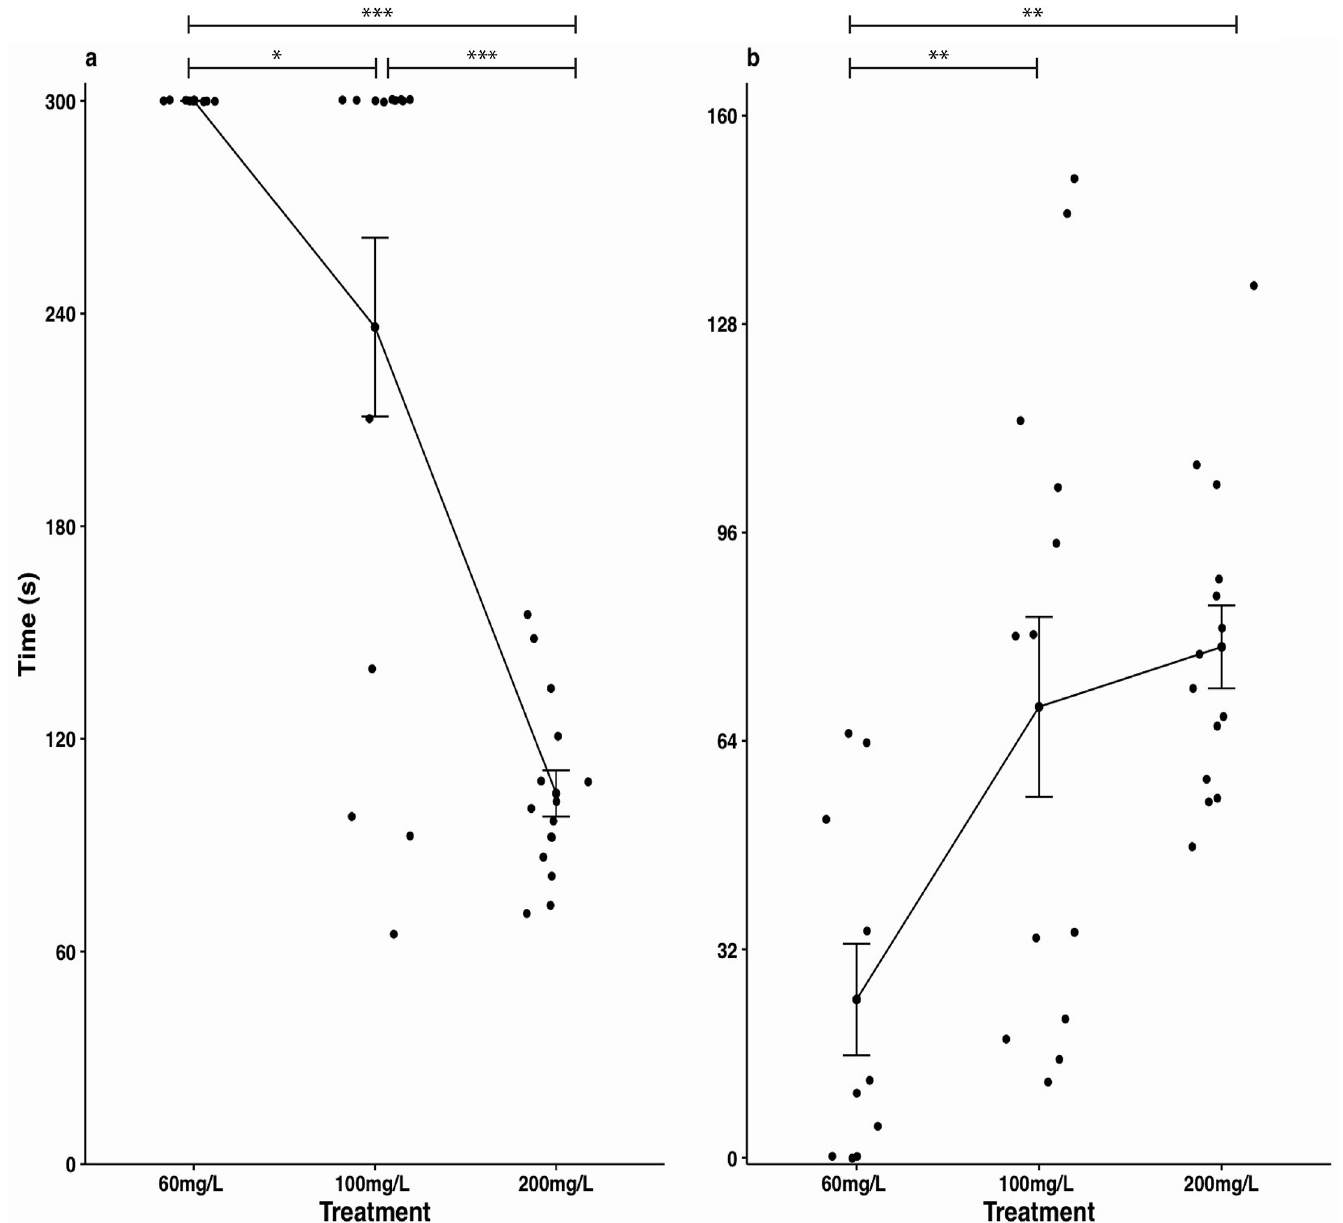
Fig 4. Anesthesia induction (a) and recovery (b) times at 15˚C for MS-222 concentrations of 60 mg/L, 100 mg/L and 200 mg/L. Times were capped at 5-minutes. � P < 0.05; �� P < 0.01; ��� P < 0.001 one-way ANOVA with Tukey’s Honestly Significant Difference (HSD) post hoc